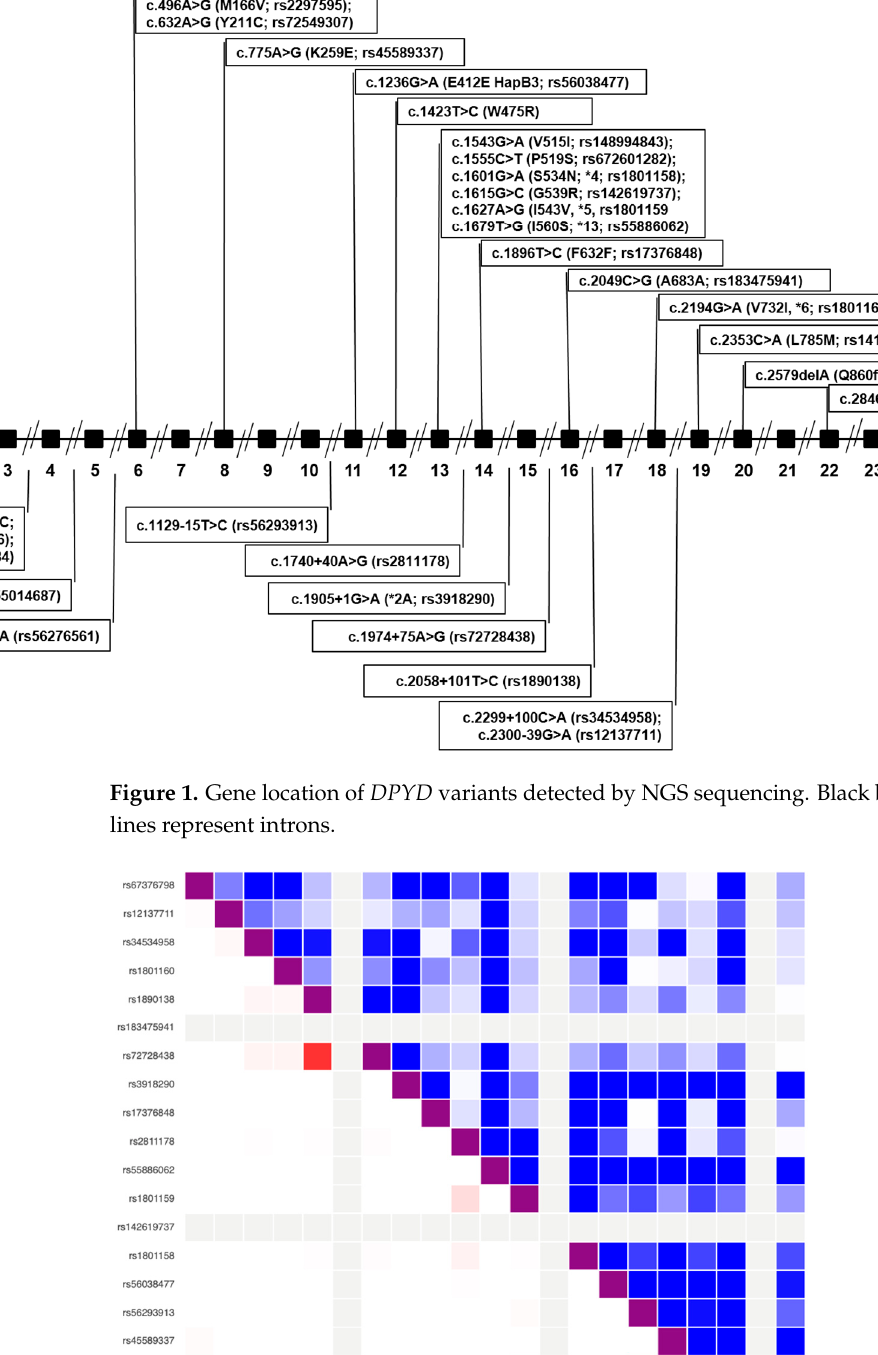
Figure 3. 5-FUDR values distribution in subjects with the AA or AG genotype compared to subjects with the GG genotype in the polymorphic site c.1974+75A>G (rs72728438). 3. Discussion The phenotypic 5-FUDR assay was previously established as clinically useful to man- age FP treatment. Furthermore, 5% of the general population has 5-FUDR values ≤ 0.85 ng/mL/10 6 cells/min and is classified as PM [32]. We have previously shown that PM sub- jects have a significantly increased risk of developing severe 5-FU toxicity, and correlated the presence of known DPYD polymorphisms with both 5-FU toxicity and low 5-FUDR values [32,33,36–39]. Our previous results confirmed that, despite the enormous benefits in terms of treatment safety brought by the system-level genotyping of recommended SNPs, a large fraction of DPD deficiencies remains unpredictable [32,33]. Thus, the imple- mentation of NGS to characterize larger DPYD regions is attractive and is becoming more and more actionable. However, broad DPYD sequencing will drastically increase the